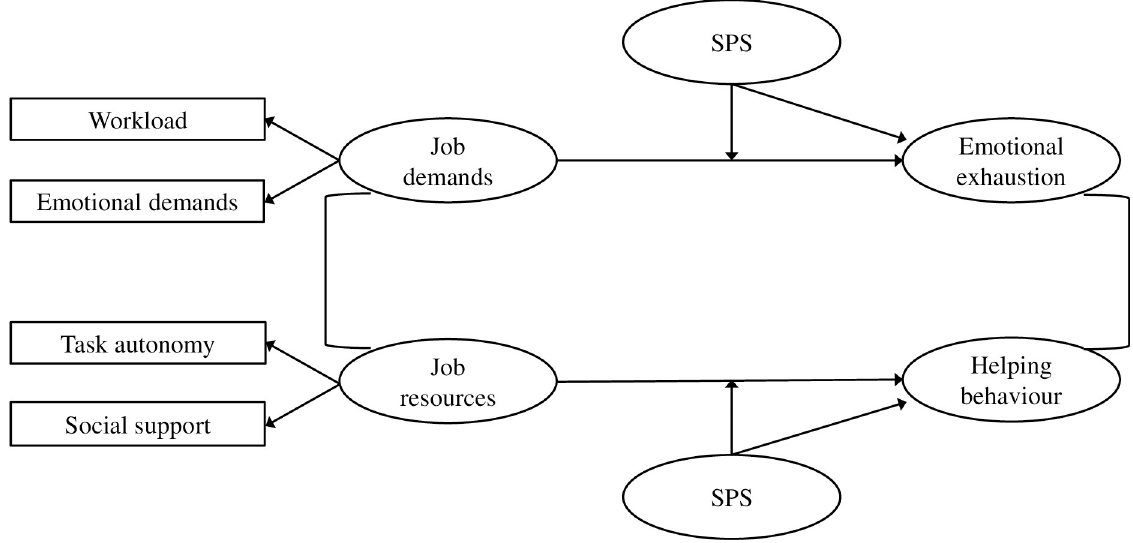
Fig 1. Theoretical